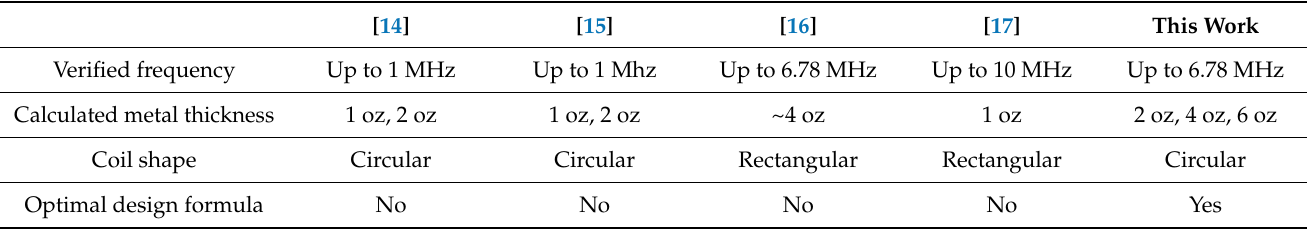
Table 3. Comparison between previous studies and this